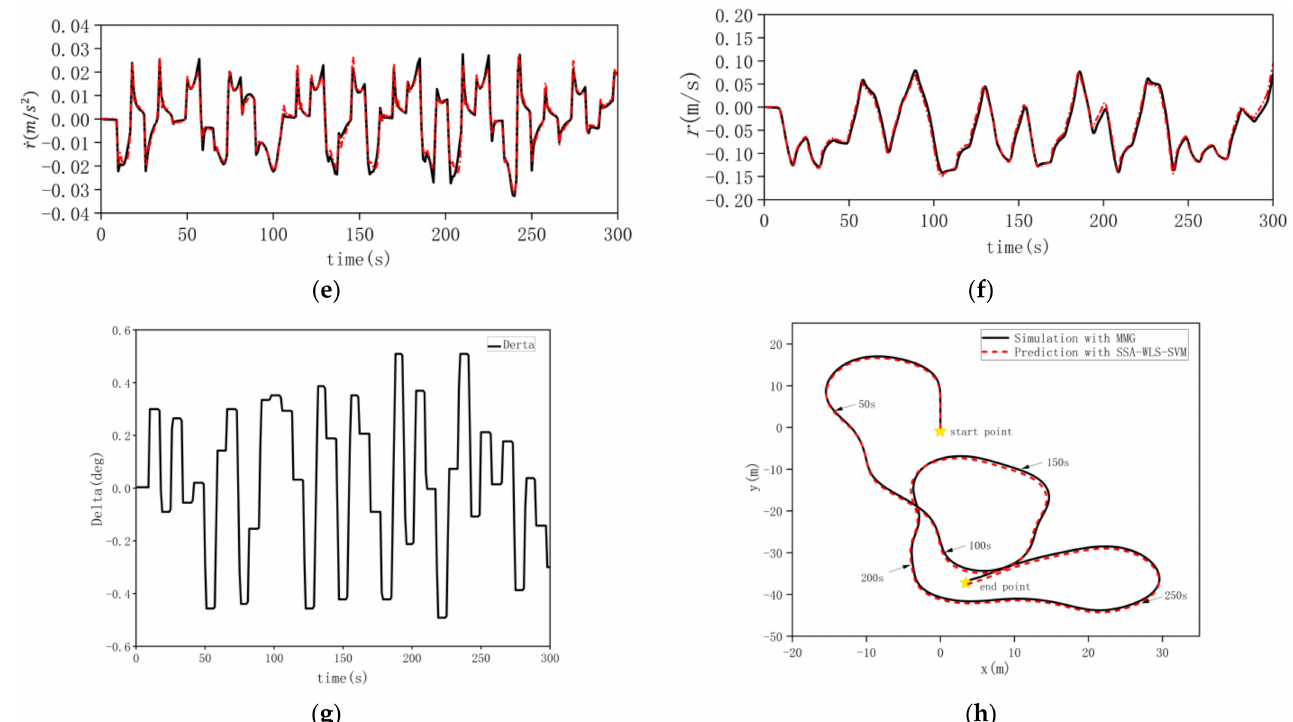
Figure 12. Comparison of the prediction with SSA-WLS-SVM and simulation in dataset 1. ( a ) Longitu- dinal acceleration. ( b ) Longitudinal velocity. ( c ) Lateral acceleration. ( d ) Lateral velocity. ( e ) Steering angular acceleration. ( f ) Steering angular speed. ( g ) Rudder angle. ( h ) Track of USV.